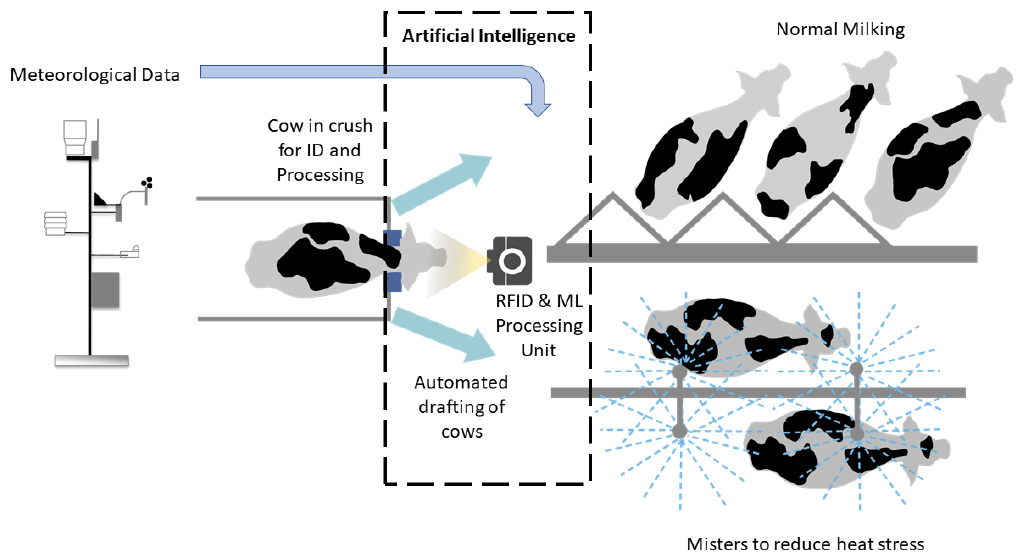
Figure 4. Proposed artificial intelligence (AI) application based on the automated processing of meteorological station and radio frequency identification system (RFID) for specific cow data input and machine learning (ML) processing. This system activates the gate system to draft cows to a cooling system or normal milking.